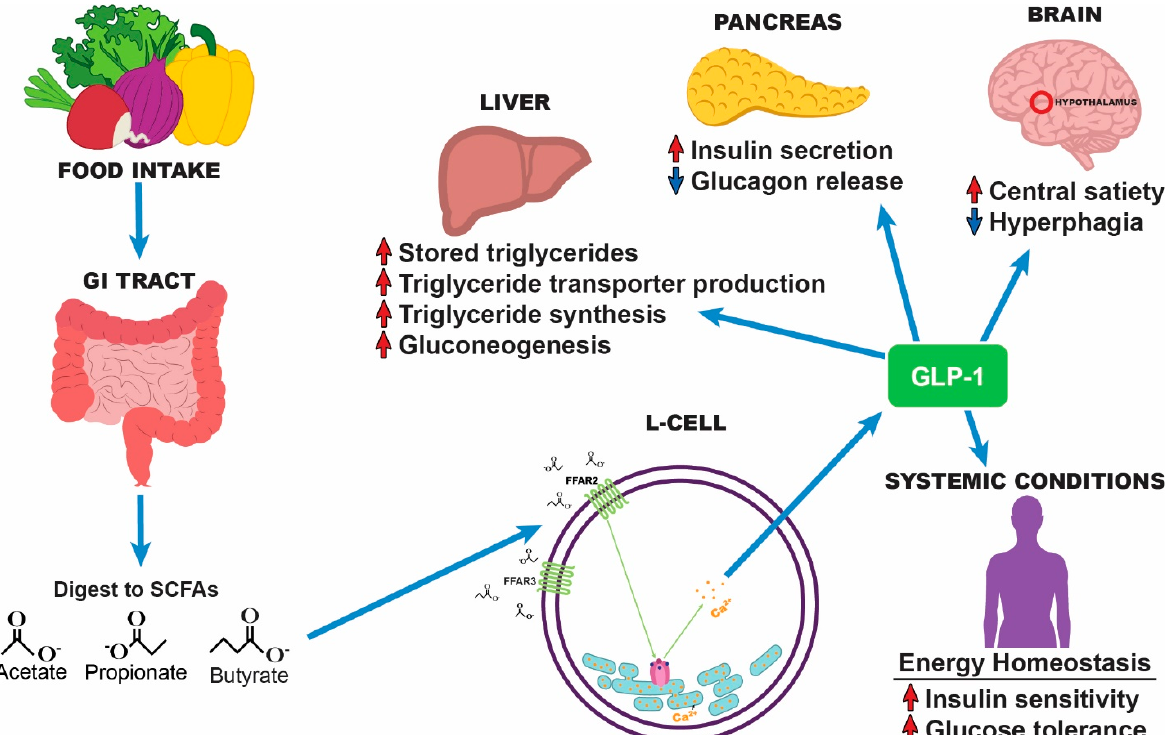
Figure 2. SCFAs bring about system-wide improvements in ACVD risk factors via GLP-1. Fol- lowing food intake, dietary fibers are digested by gut microbiota into SCFAs including acetate, propionate, and butyrate. These SCFAs activate intestinal L cells, leading to the release of GLP-1 both independently of and in conjunction with FFAR2 and FFAR3 activation. GLP-1 modulates a variety of organ functions including the liver, pancreas, and brain. It also systemically improves insulin sensitivity and glucose tolerance. This ability to improve various cardiovascular and metabolic risk factors for ACVD implicates GLP-1 and its synthetic mimetics as a viable treatment option for ath- erosclerosis.